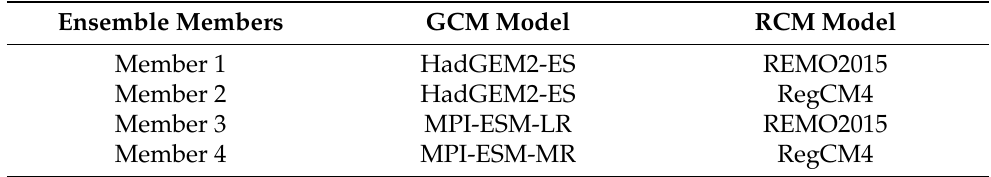
Table 1. Summary of ensemble